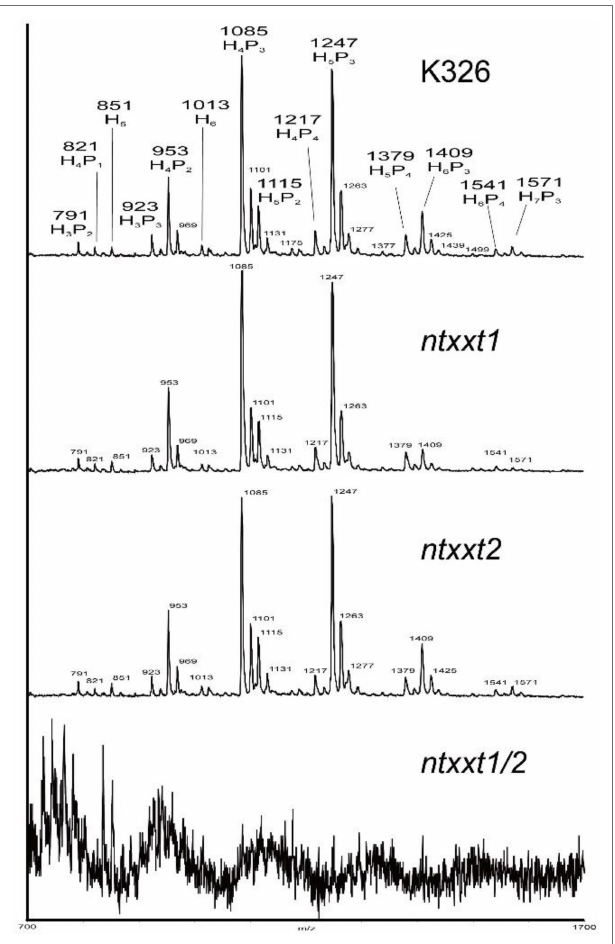
FIGURE 4 | MALDI-TOF spectra of the XyG oligosaccharides generated from the 4 M KOH-soluble of AIR obtained from K326, ntxxt1 , ntxxt2 , and ntxxt1/2 mutants